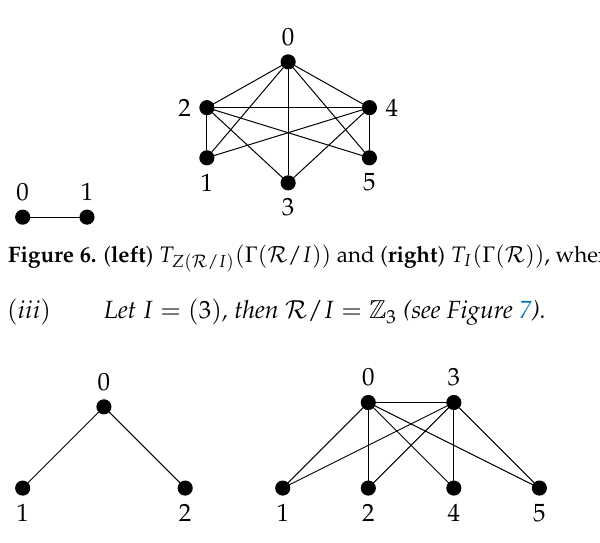
Figure 7. ( left ) T Z ( R / I ) ( Γ ( R / I )) and ( right ) T I ( Γ ( R )) , when R = Z 6 and I = ( 3 ) . ( iv ) Let I = Z R / I = ( 0 ) (see Figure 8). 6 , then